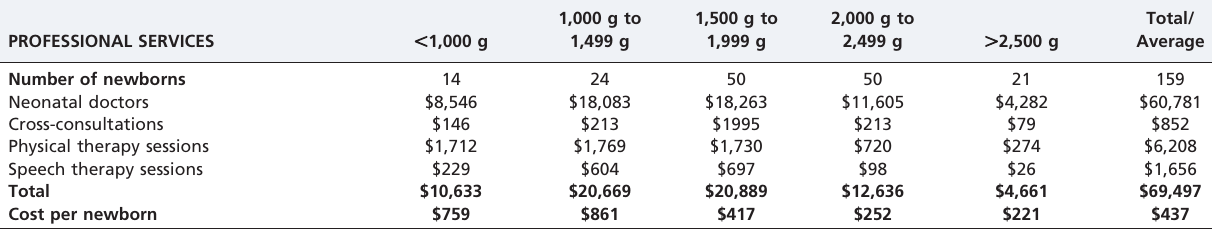
Table 4 - Costs for diagnostic tests in premature newborns. ADT Number of newborns